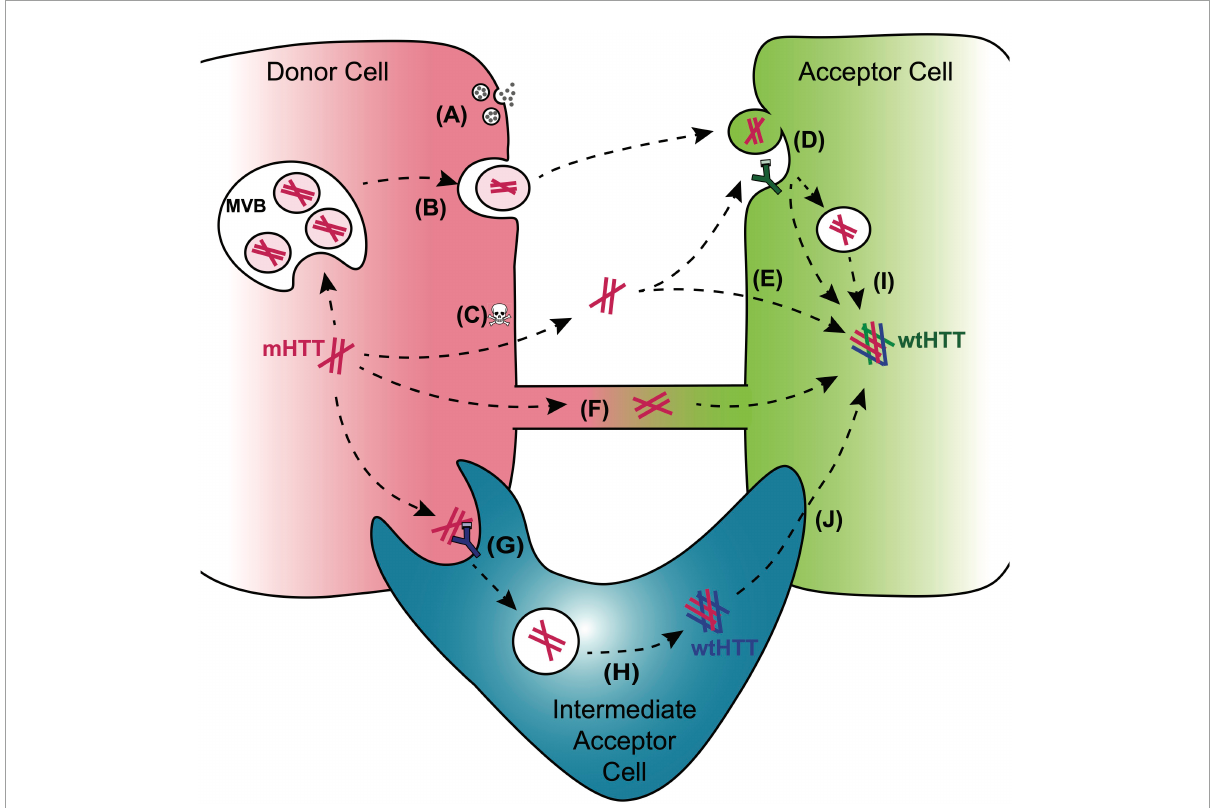
FIGURE3 Mechanisms for cell-to-cell transmission of mHTT. Pathways reported to mediate inter-cellular transmission of mHTT aggregates are illustrated here and described in more detail in the text. mHTT aggregate release from donor cells (red cell; left) may be coupled to synaptic activity in presynaptic neurons (A) , could occur with in exosomes released from a multivesicular body (MVB) (B) , or could be passively released from dying cells (C) . Entry of prion-like mHTT aggregates into acceptor cells has been reported to occur via bulk-phase or receptor-mediated endocytosis (D) , direct penetration of the plasma membrane (E) , or alternatively, aggregates may transfer directly from one cell cytoplasm to another via membrane-enclosed tunneling nanotubes (F) . Phagocytic glia may play double-edged roles in HD through receptor-mediated engulfment of aggregates from neurons (G) , which can lead to either clearance in the lysosome or aggregate “escape” from the glial phagolysosomal system prior to degradation (H) . Disruption of normal endosomal or autophagosomal pathways may also underlie mHTT aggregate transmission to the cytoplasm of non-phagocytic cells (I) . mHTT aggregates that evade lysosomal degradation as a result of endo/phagolysosomal defects could generate cytoplasmic reservoirs of prion-like mHTT species in “intermediate acceptor cells” (e.g., glia) and enhance aggregate seed transmission to other cells, such as post-synaptic neurons (J)